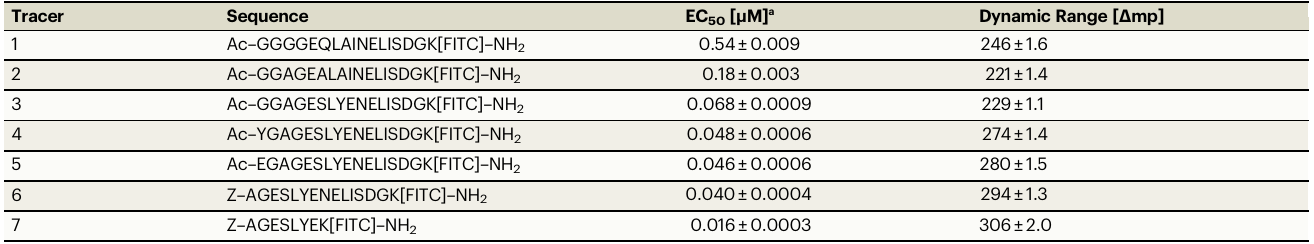
Table 1 | Binding af fi nities and dynamic ranges of tracers 1 – 7